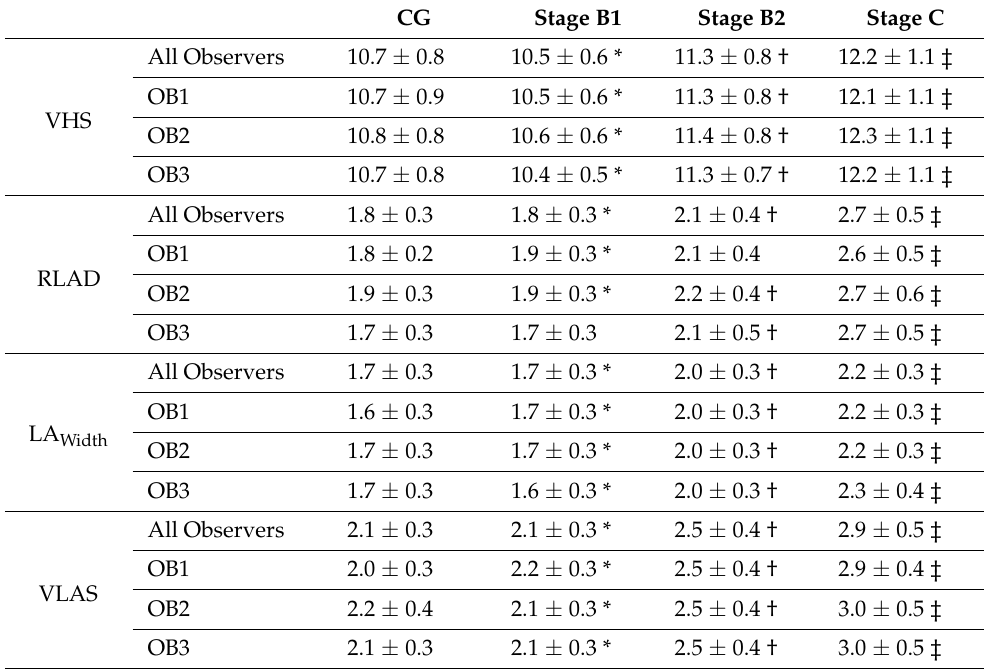
Table 2. Radiographic measurement among the different observers in conventional radiographs.